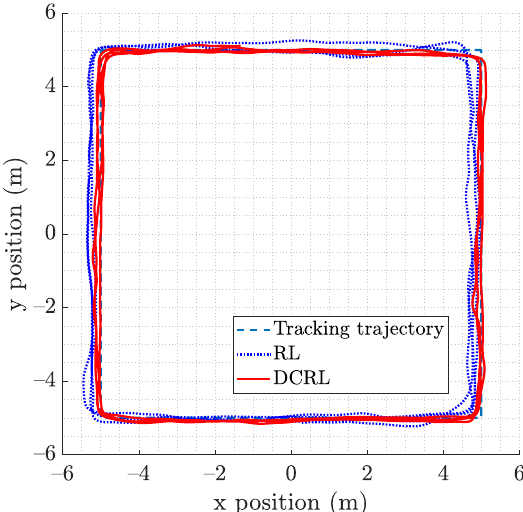
Figure 7. The position of tracking a 10 m square trajectory in an outdoor experiment. The GPS sensor was used for position information